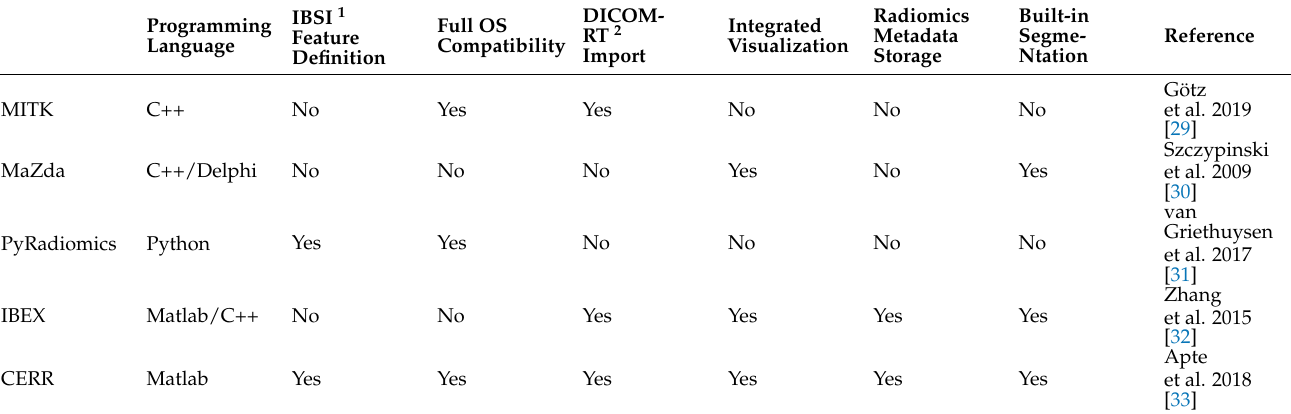
Table 1. Primary characteristics of publicly available open-source radiomics extraction tools.